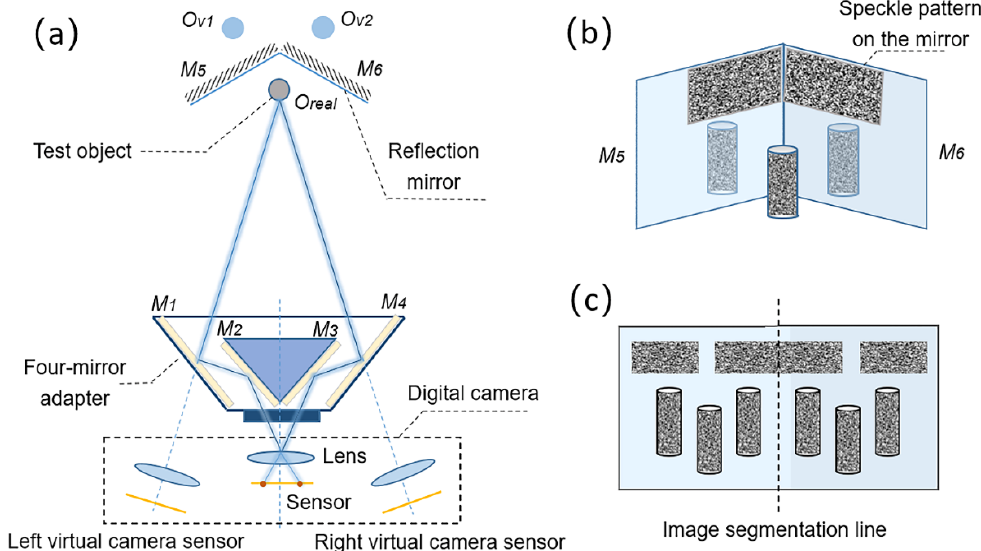
Figure 1. Schematic diagram showing: ( a ) optical paths of the proposed mirror-assisted single-camera panoramic DIC system, ( b ) the front view of the object and planar mirrors behind it, ( c ) the captured image.